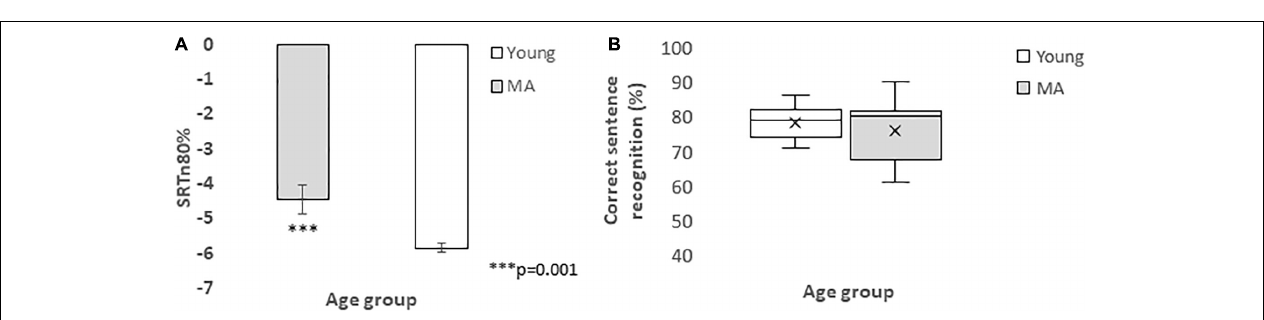
FIGURE 2 | in panel (A) , mean ( ± se) of SRTn 80% sentence recognition of young (white) and MA (gray) groups, in the single task. Note that the MA group needed a more positive SNR than the young group, even when the primary task was performed singly. In panel (B) distribution of correct sentence recognition for the young (white) and MA (gray), in the dual-task , performed at the individual SNR, obtained when tested singly. Lower and upper box boundaries represent the 25th-75th percentiles, lower and upper error bars represent 10th and 90th percentiles, respectively. The horizontal line inside the box represents the median and the X – the mean. Note the larger distribution of the MA results, albeit almost similar median and mean scores.